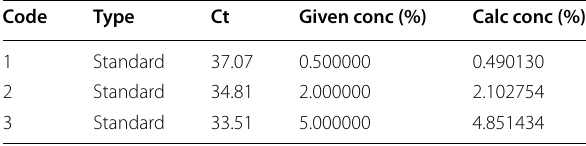
Table 4 Calculated initial concentration percent for the standard curve constructed from different dilutions from the Fluka CRM